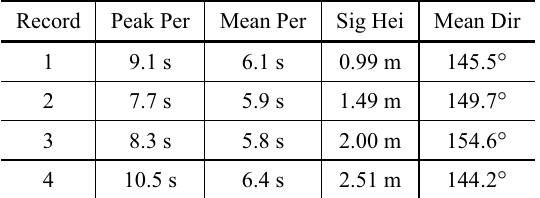
Measurements made by the Waverider buoy used as boundary conditions for the physical model and for the numerical models. The values listed are Peak Period (Peak Per), Mean Period (Mean Per), Significant Wave Height (Sig Hei) and Mean Direction (Mean Dir), the direction waves are coming from (compass